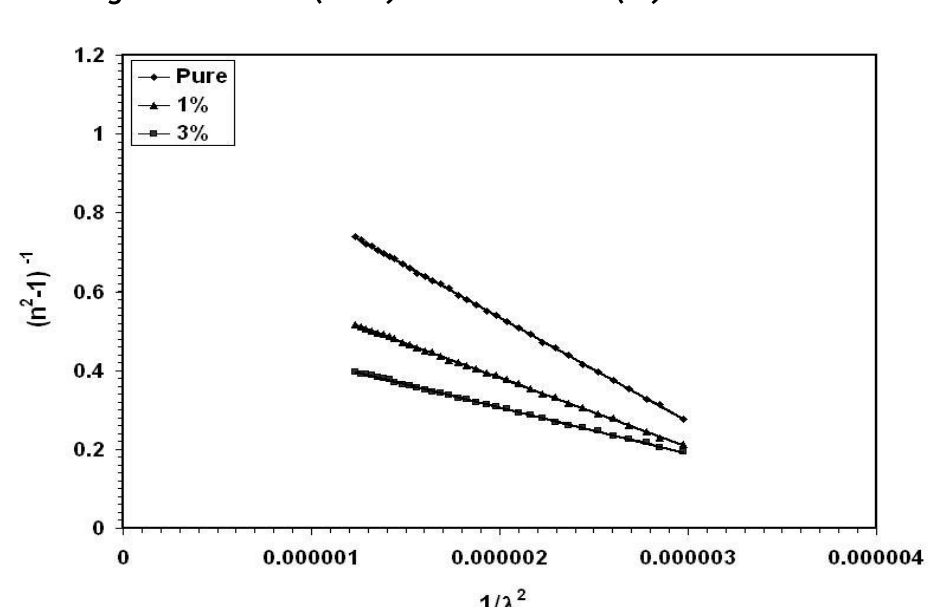
Fig. 5: Variation in (n 2 – 1) −1 as a function of (λ) -2 of ZnO:In